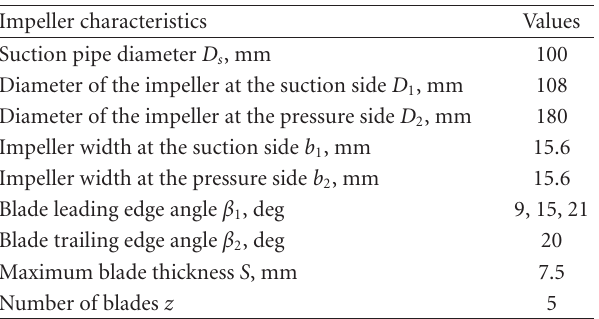
Table 1: Main characteristics of the tested